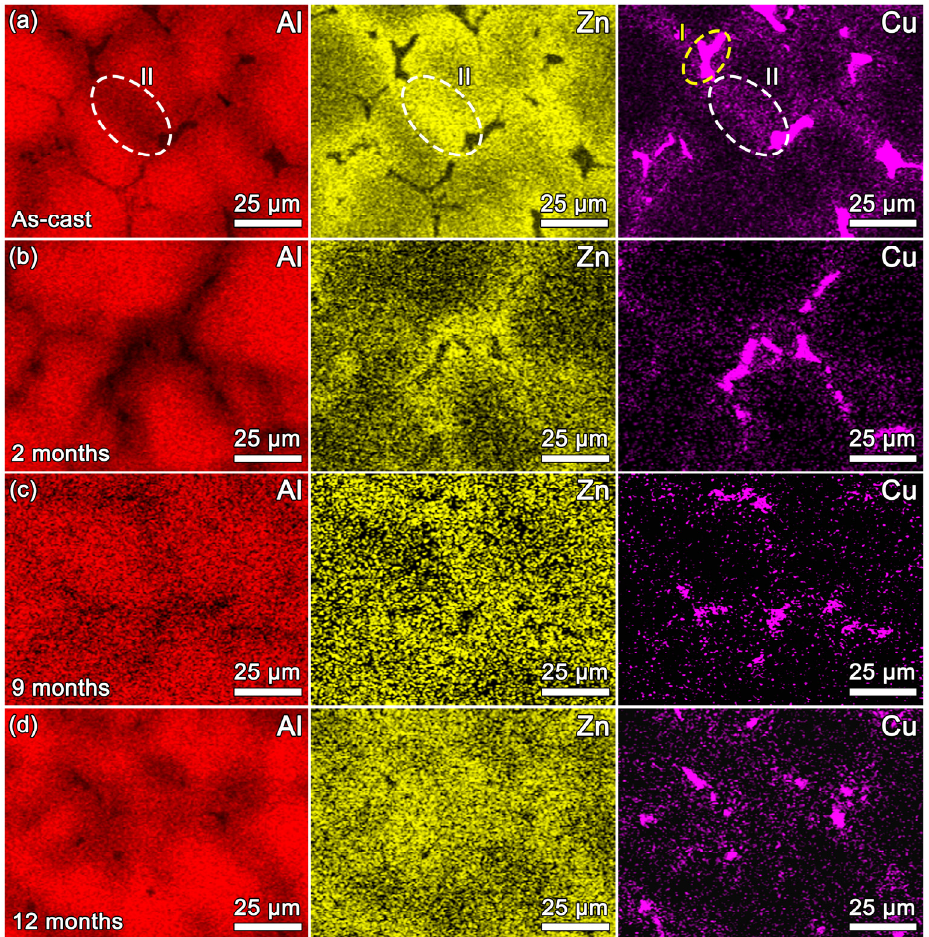
Figure 4. Elemental mapping results of Al-20Zn-3Cu: ( a ) as-cast, ( b ) 2 months, ( c ) 9 months, and ( d ) 12 months. Area I and II respectively indicate the pure Cu and the eutectoid lamellar structure.